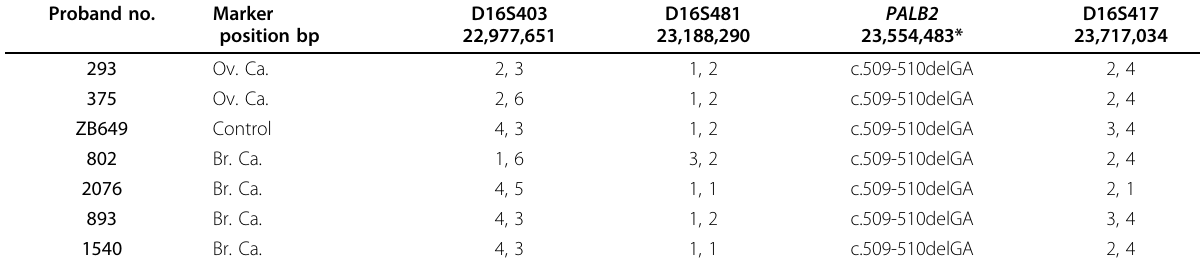
Table 4 Results of genotyping of PALB2 mutation carriers Proband